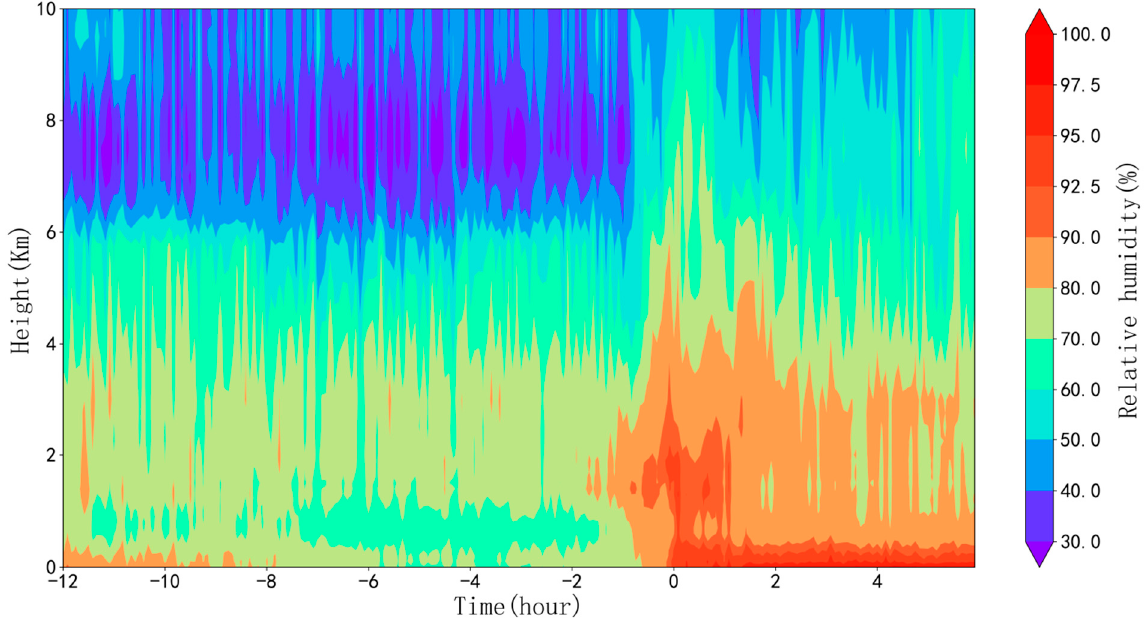
Figure 4. Vertical distributions of relative humidity during 12 h before and 6 h after the start of HRs in 2021.